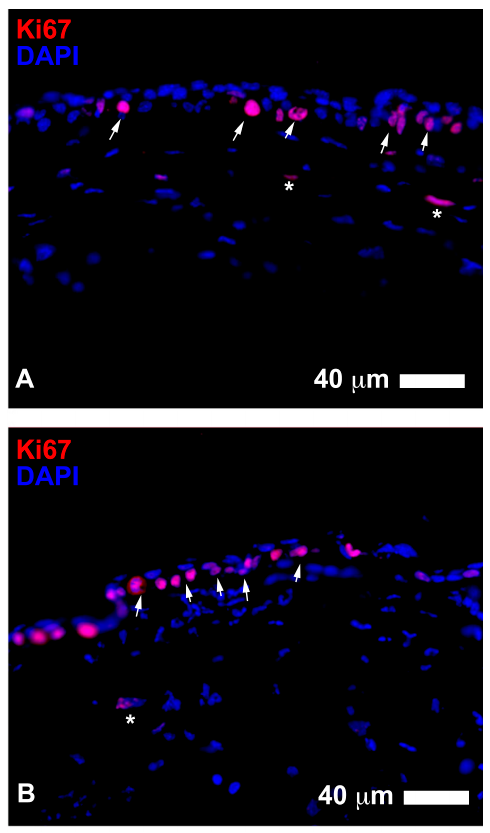
Figure 4. Images of Ki67 positive cells (in red) in the central epithelium of wound healing corneas treated with adipose-derived stem cells ADSC for three days ( A ) compared to the control eyes ( B ). Both groups showed a high number of proliferating cells in the basal cell layer of the regenerating epithelium (arrows). Note a slightly higher level of organization in stem cell treated cornea. Some proliferating cells could be found in the stroma (asterisks) (Scale bars: 40 µm).